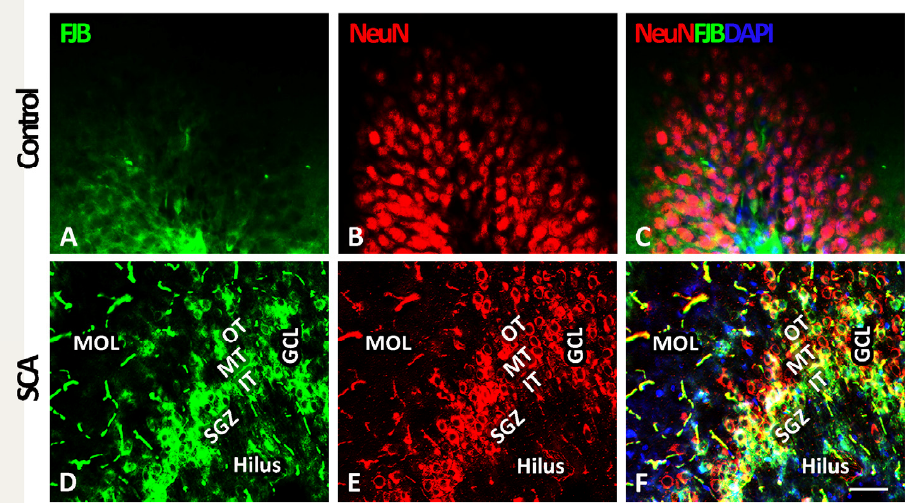
Figure 1. SCA (suction cortical ablation) induces neuronal death predominantly in the inner- and mid-third of the granule cell layer (GCL) and subgranular zone (SGZ) of the dentate gyrus (DG). ( A – C ) FJB (green fluorescence) staining in the control sections was weak, and FJB-positive cells were rare. ( D ) After SCA, a substantial increase in FJB-immunoreactivity indicates increased cellular degeneration. ( E ) Reduced NeuN (red) immunoreactivity indicates neuronal loss. ( F ) FJB (green), NeuN (red), and DAPI (blue) fluorescence show strong co-staining, revealing the neuronal identity of degenerating cells. In ( C , F ), the sections were counterstained with DAPI (blue) to visualize cell nuclei. Most affected are the inner- and mid-third of the GCL and the SGZ, indicating that neurons are undergoing, degeneration particularly in these compartments. FJB/NeuN-positive neurons were occasionally seen in the molecular layer (MOL) of the DG and the hilus. Outer-third (OT), mid-third (MT), inner-third (IT) of the GCL, and the SGZ of the DG. Scale bar 50 µ